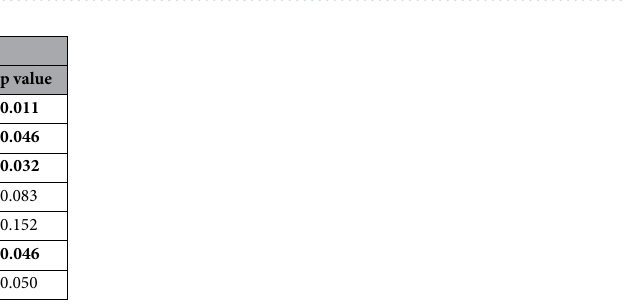
Figure 2. Spearman correlation analysis of serum MMP9 versus serum IL-6 (panel A ; r s : 0.345, p < 0.0001), versus MPO (panel B ; r s : 0.604, p < 0.0001), versus neutrophils (panel C ; r s : 0.611, p < 0.0001), and versus monocytes (panel D ; r s : 0.403, p < 0.0001). IL interleukin, MMP matrix metalloproteinase, MPO myeloperoxidase.